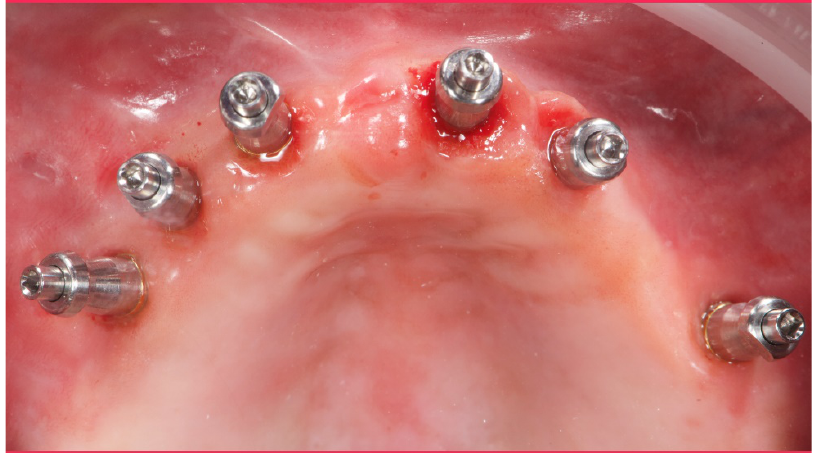
Figure 7. Scan bodies mounted on OT Equator. Note the strong disparallelism among the dental implants.